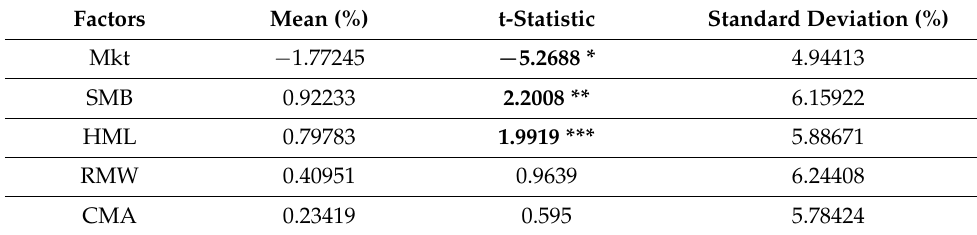
Table 1. Means, t-statistics and standard deviations of the factor monthly returns.